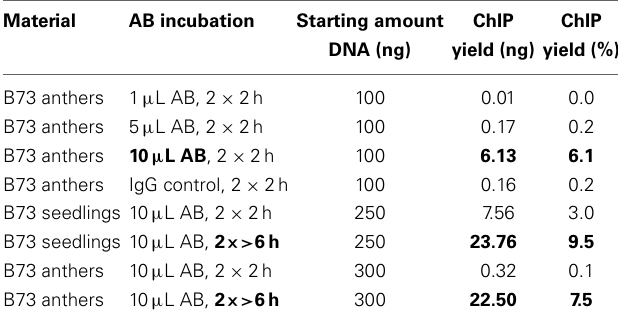
Table 2 | Optimizing antibody incubation.